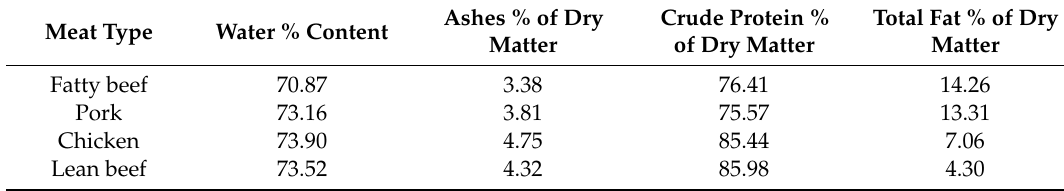
Table 4. Chemical composition of the meat